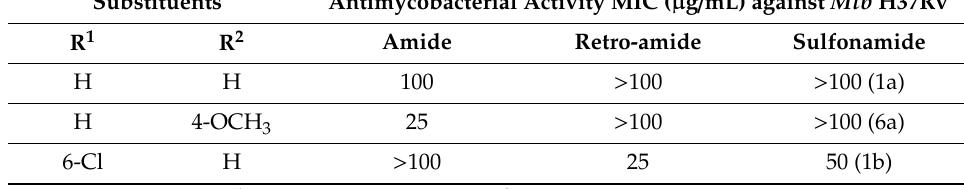
Table 4. Comparison between the antimycobacterial activity against Mtb H37Rv expressed by the minimum inhibitory concentrations (MIC) in µ g /